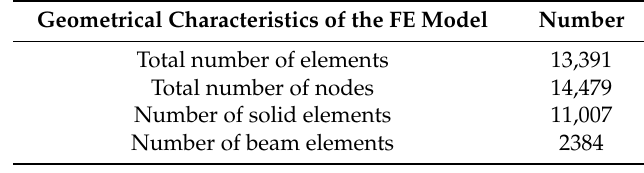
Table 4. Geometrical characteristics of the finite element (FE) model.